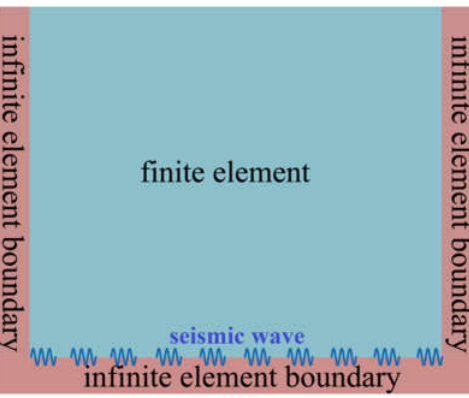
Figure 5. Mesh model used in the calculations: ( a ) homogeneous rock mass site (Model 1), ( b ) hori- zontally layered site (Model 2) and ( c ) layered site with strata dip angle of 10° (Model 3).